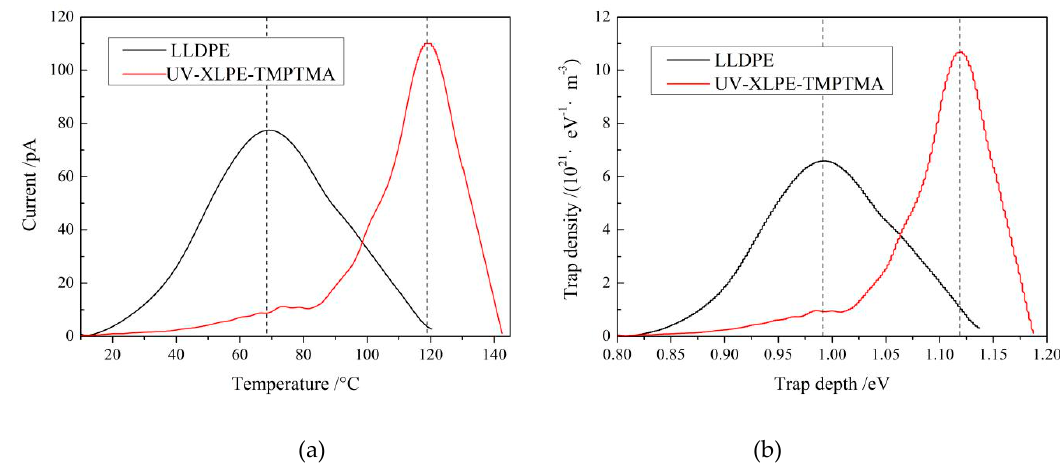
Figure 4. ( a ) Temperature spectra of thermally stimulated depolarization currents and ( b ) the trap level distributions of LLDPE and UV-XLPE- TMPTMA . distributions of LLDPE and